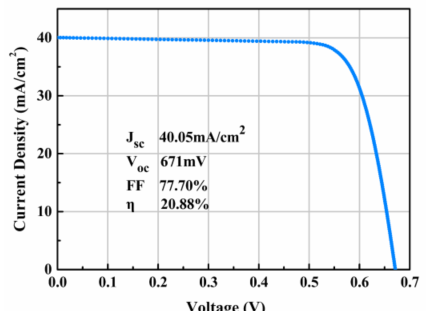
Figure 10. The J-V curve of the best IBC solar cell measured under AM 1.5G, 0.1 W / cm 2 and 25 ◦ C; the sample sheet resistance was 95 Ω / square at the front surface doped layer. The active cell area was 2 × 2 cm 2